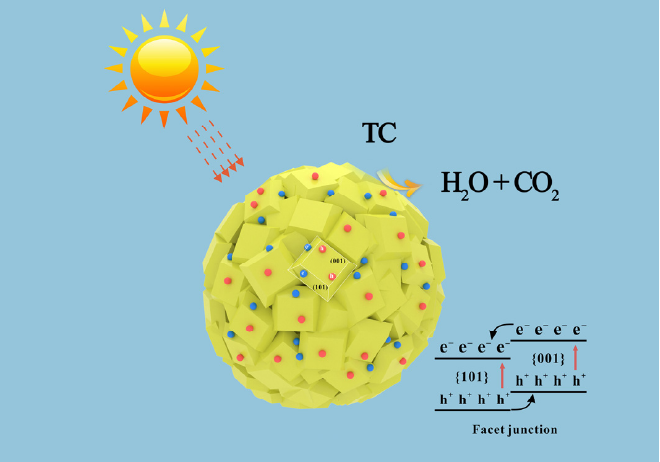
Figure 7. Schematic diagram of photocatalytic degradation mechanism.